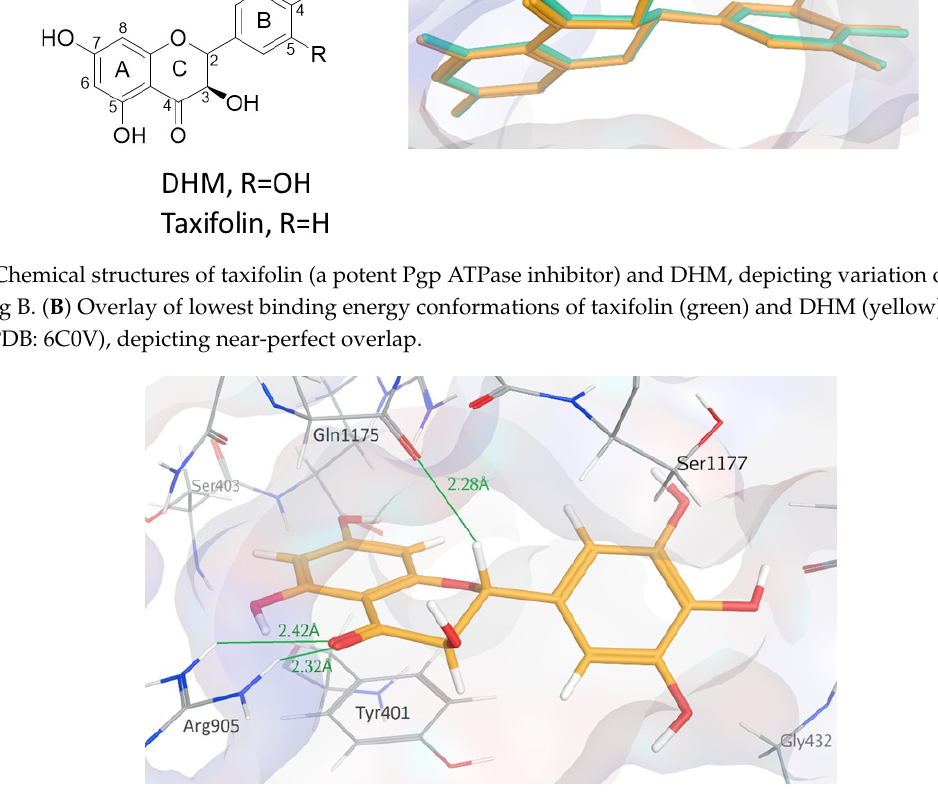
Figure 6. Lowest energy binding conformation of DHM (yellow) in NBD1 of human Pgp (PDB:6C0V). Atoms are displayed in the following colors: oxygen (red), nitrogen (blue), hydrogen (white), and carbon (grey, except DHM). Hydrogen bonds and distances are displayed in green. As depicted, in the lowest binding energy conformation, the 2-hydrogen and 3-carbonyl of DHM form hydrogen bond interactions with Gln1175 and Arg905 residues, respectively.